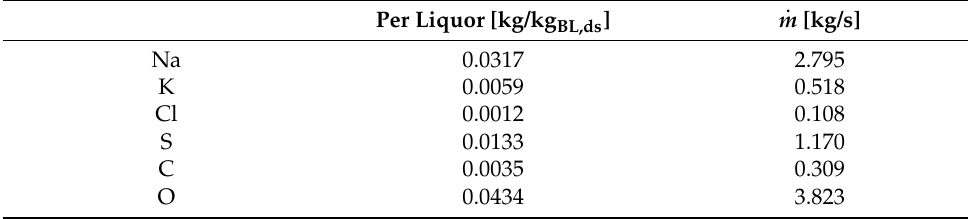
Table A2. Ash elemental composition, relative to black liquor dry solids, and as mass